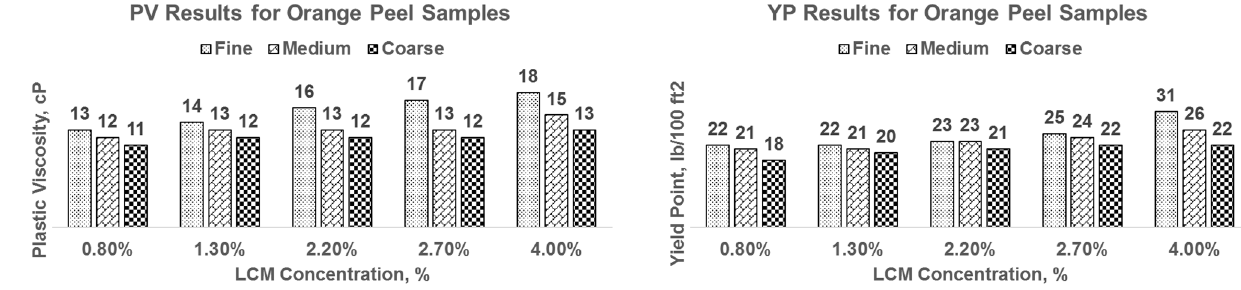
Fig. 1 Plastic viscosity results for orange peel samples